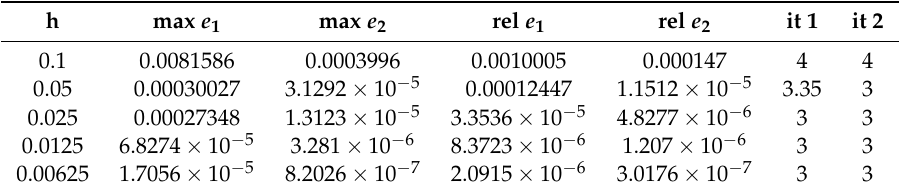
Table 2. Multisplitting Modern version.